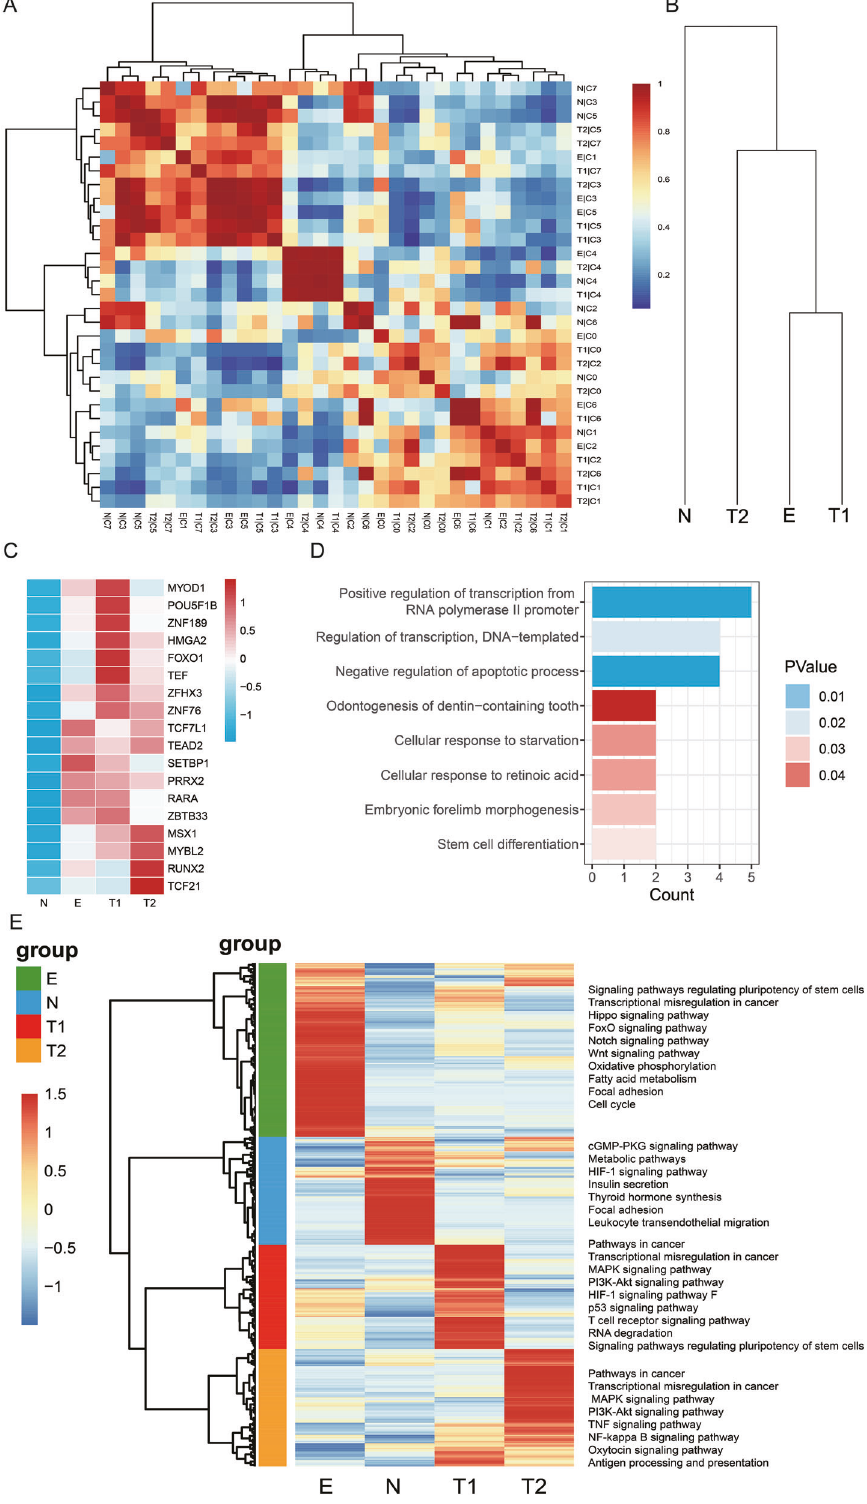
Fig. 2 Comparison of diverse clusters and samples. A Heatmap showing conserved cell types in OCs, normal ovary, and embryo. B Evolutionary tree illustrating the similarity between samples. C Heatmap of 18 differential regulons by SCENIC for different samples. D Functional analysis of the 18 regulons. E Heatmap illustrating diverse genes and relative pathways in four